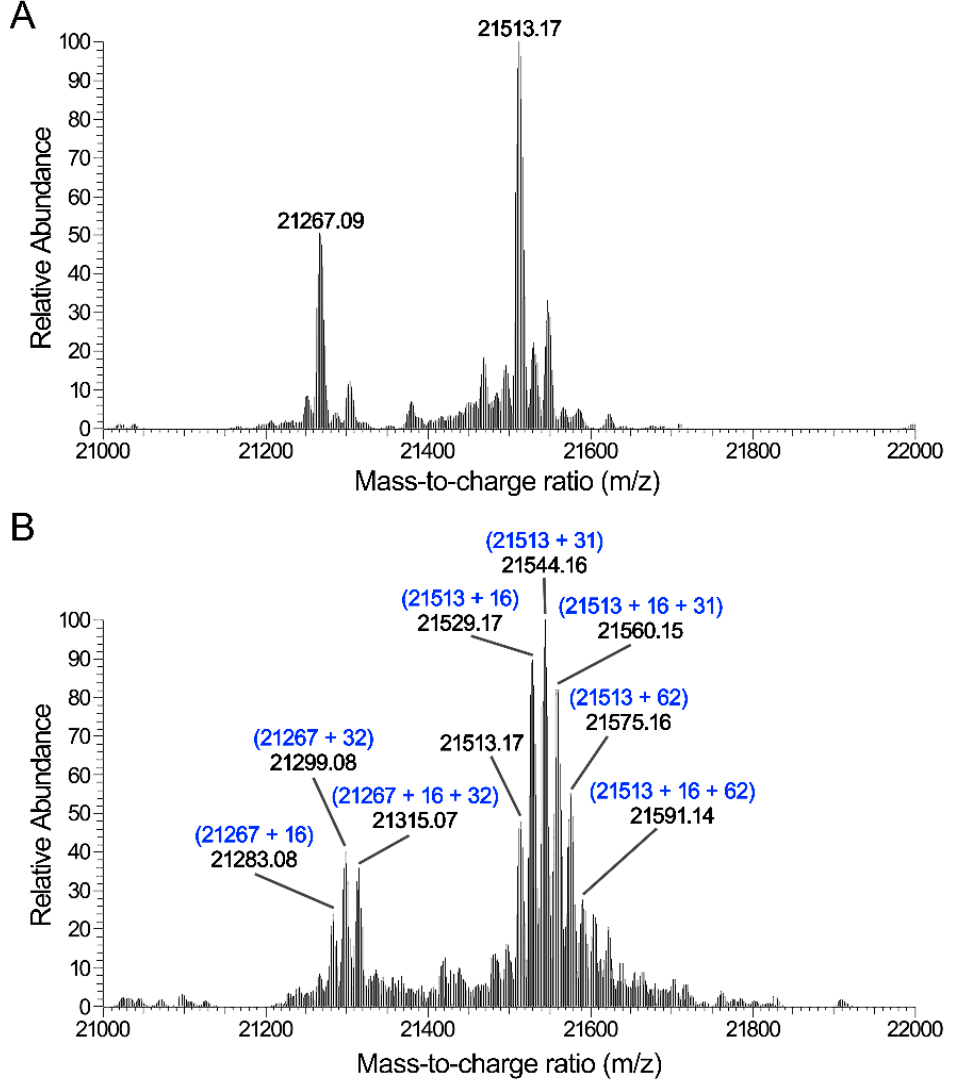
Figure 6. Identification of the modifications of SaClpP induced by plasma treatment. ( A ) Mass spectrum of untreated SaClpP. ( B ) Mass spectrum of the plasma-treated SaClpP. A cluster of peaks with mass differences of 16, 31, 32, or 62 Da are